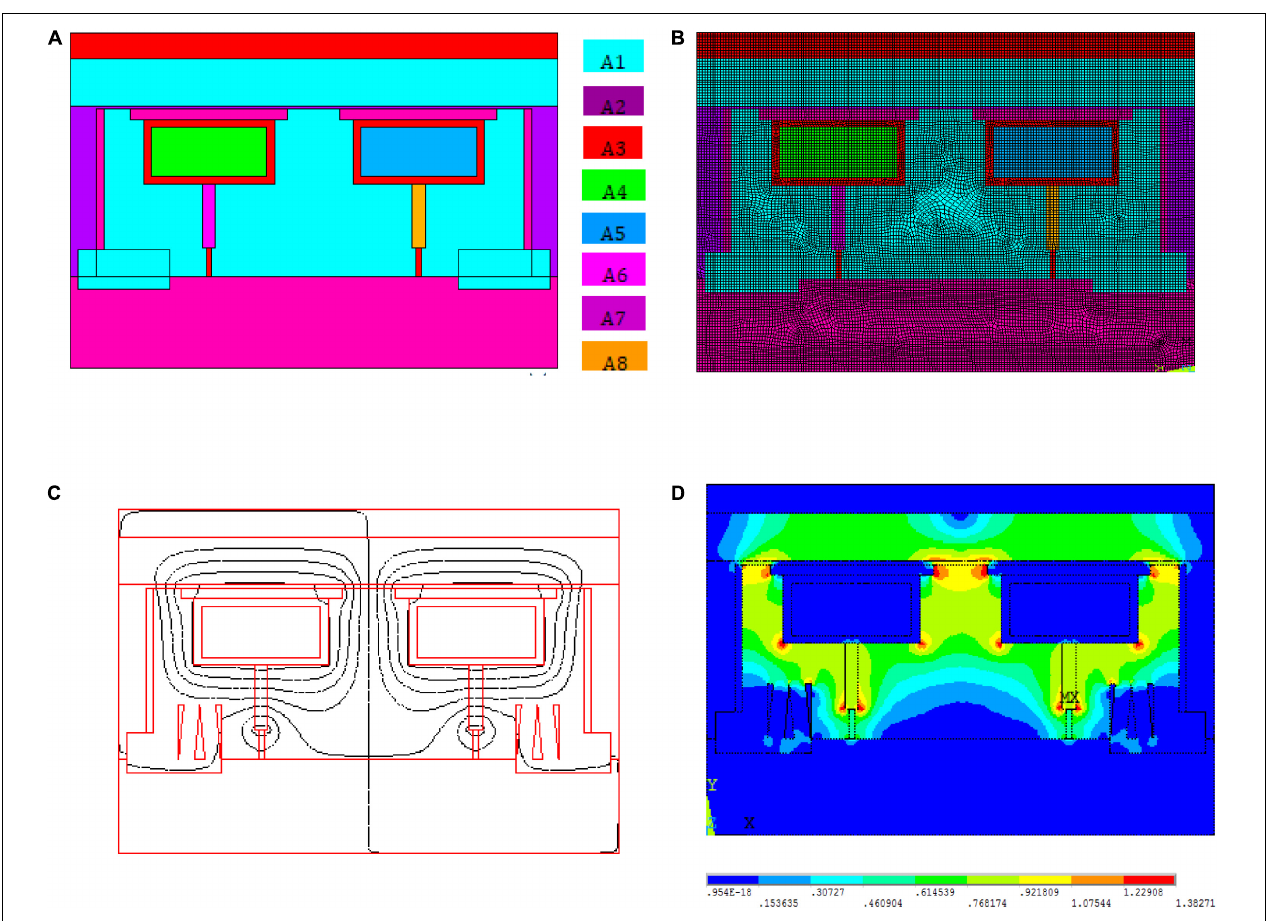
FIGURE 3 | Finite element model of magnetic circuit structure and results: (A) material partition, (B) finite element mesh, (C) distribution of magnetic lines, and (D) total flux density distribution.